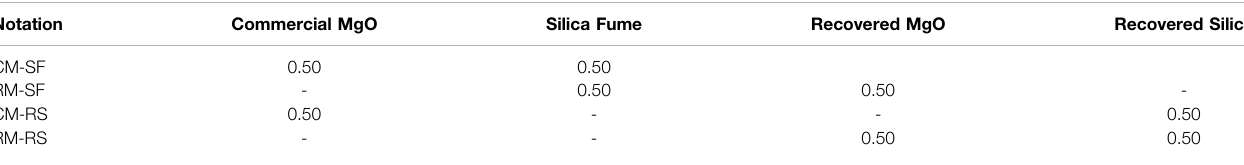
TABLE 2 | Mix design